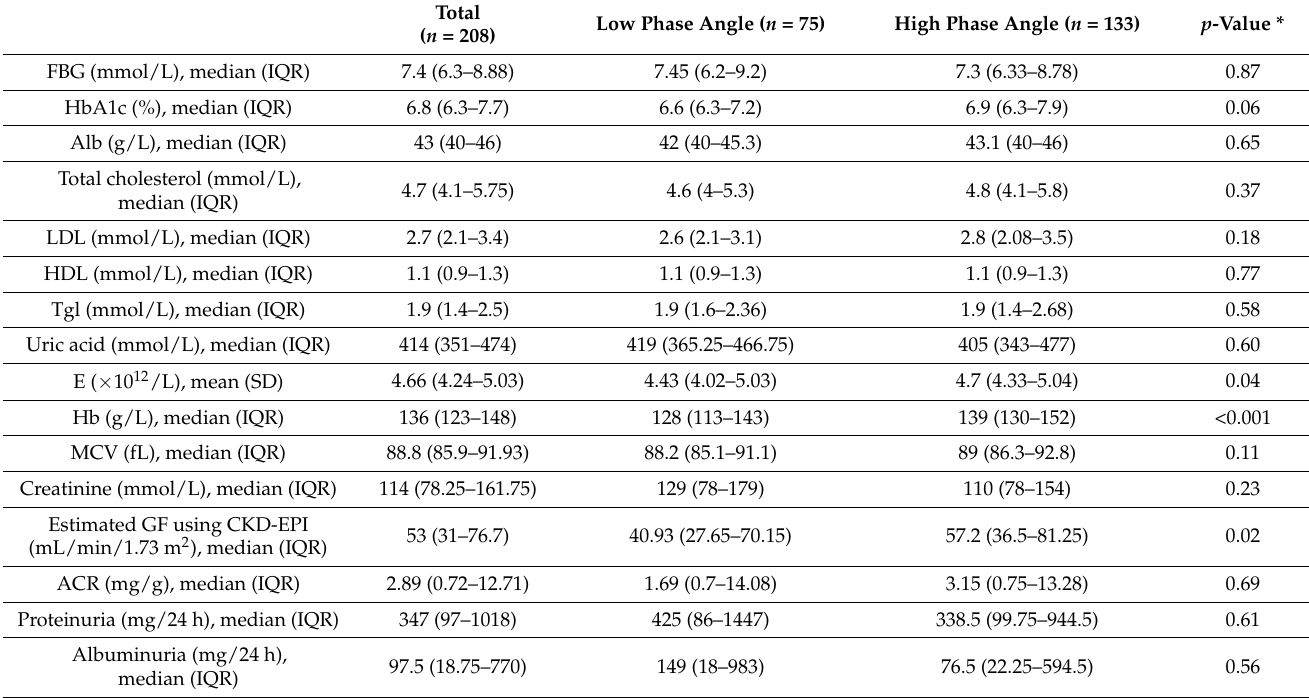
Table 2. Biochemical parameters regarding differences in phase-angle categories in all study